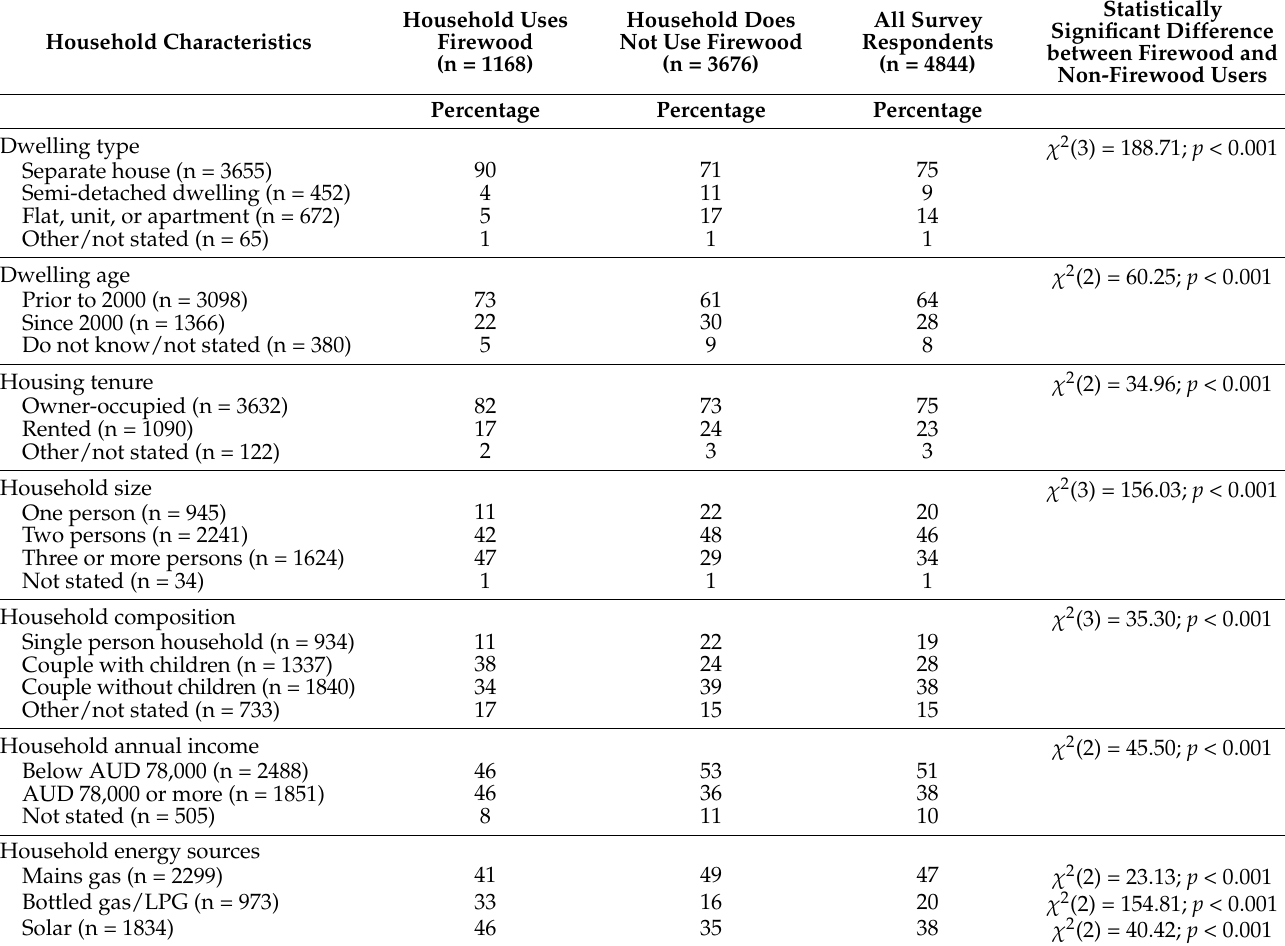
Table 4. Household characteristics of survey sample: firewood users vs. non-firewood users.